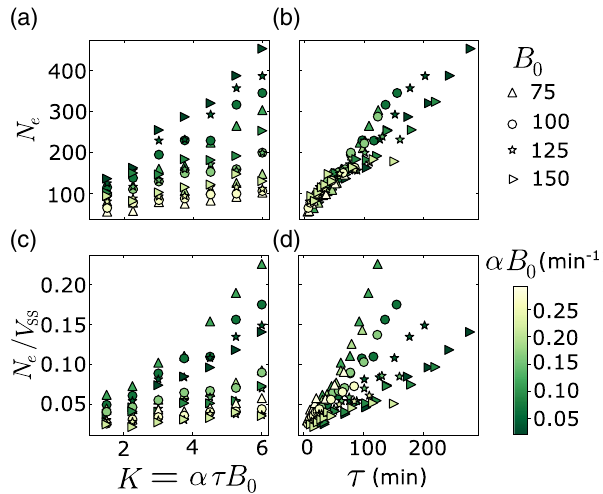
FIG. 16. Effective population size N e over a range of B 0 values shown: (a) unnormalized and as a function of K ; (b) unnormalized and as a function of τ ; (c) normalized by V and as a function of SS K ; (d) normalized by V and as a function of τ . Color indicates SS − 1 . B α B α B 0 in min 0 and 0 were varied as they are the quantities one would measure independently in experiments. Effective